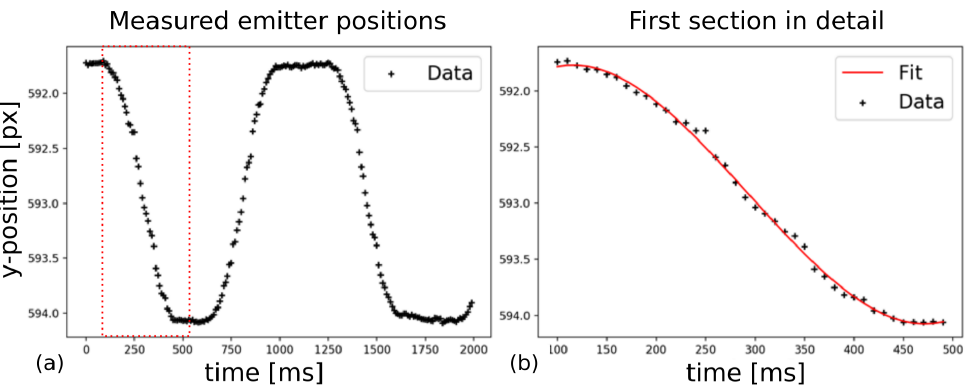
Figure 4. Measured positions of the up and down movement of the light emitter mounted on the y-stage ( a ) and zoom to the time range from 100ms to 500ms ( b ). Resulting measurement accuracy is